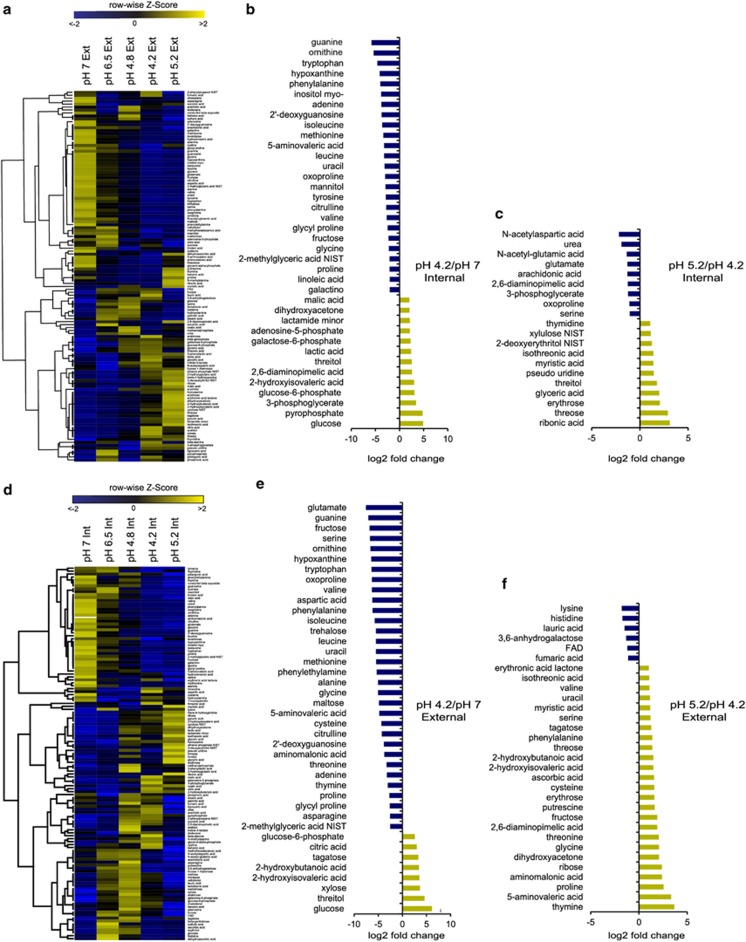
Global metabolite profiles reflect temporal changes within extra- and intracellular biofilm fractions. (a and d) Hierarchical cluster analyses of metabolites obtained from (a) intracellular extracts of biofilms across different pH stages and (d) supernatant (extracellular) extracts of biofilms across different pH stages by gas chromatography-mass spectrometry. Peak height data for each identified compound within each row were normalized using the z-score. Yellow indicates high relative metabolite concentrations (z-score values ⩾2); blue indicate low relative metabolite concentrations (z-score values ⩽2); black indicate the median z-score values. (a and d) Metabolites showing significant fold change comparisons between pH stages (Fold change <log2 or >log2). (b) Relative metabolite differences of the intracellular environment between the lowest pH stage (pH 4.2) and neutral pH (prior to glucose amendment). (c) Relative supernatant differences between the lowest pH stage and the recovery stage (pH 5.2) representing intracellular metabolites changing during the pH recovery phase. (e) Relative differences in metabolites from the extracellular environment between the lowest pH stage (pH 4.2) and neutral pH (prior to glucose amendment). (f) Relative differences in metabolites from the extracellular environment between the lowest pH stage and the recovery stage (pH 5.2).